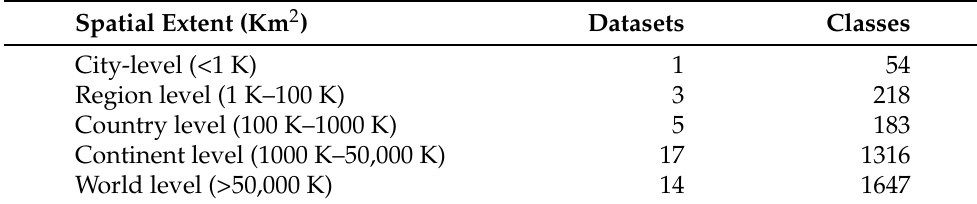
Table 4. Datasets and classes classified by the size of their spatial